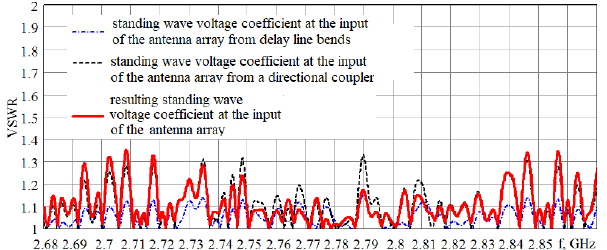
FIGURE 17. A typical implementation of the voltage standing wave ratio at the input of the antenna array with serial-parallel power supply of emitters after iterative optimization of the power divider